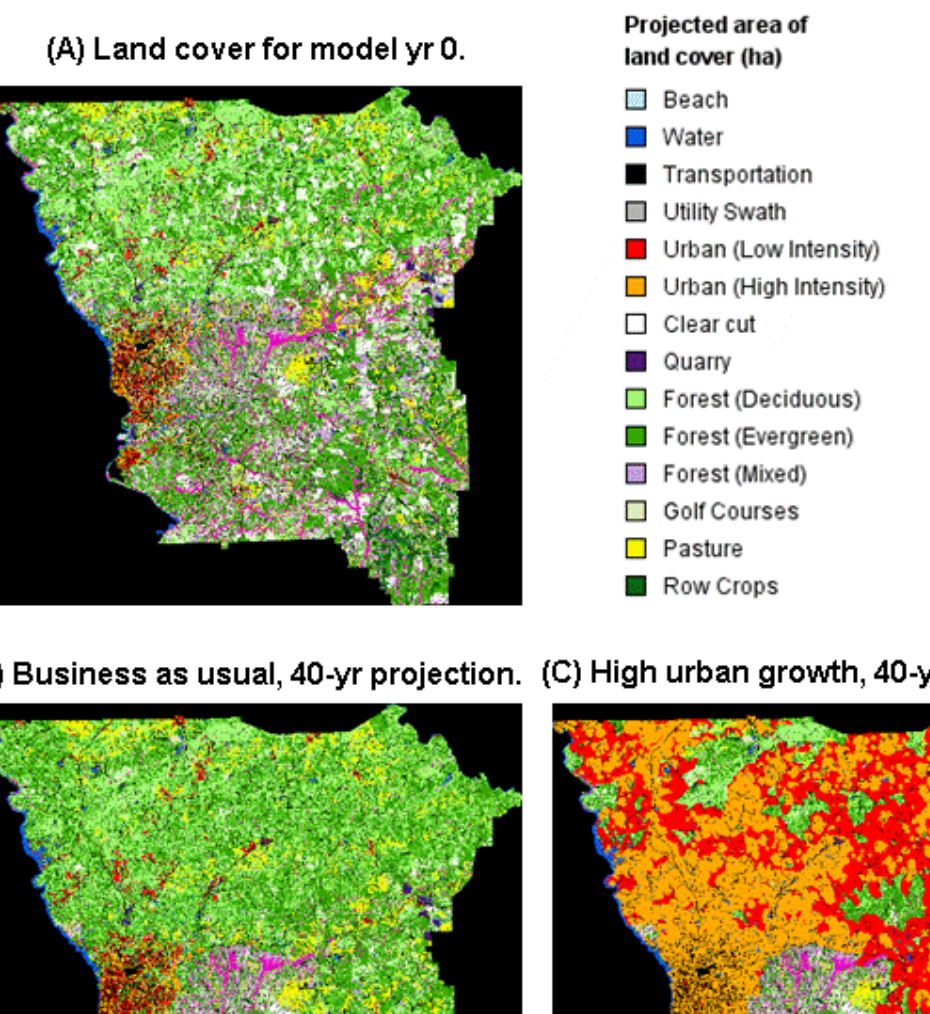
Fig. 3. Maps of land cover projected by the Regional Simulator (RSim) model at the end of the projection time